Question: Judging by this figure, is the value going up or going down?
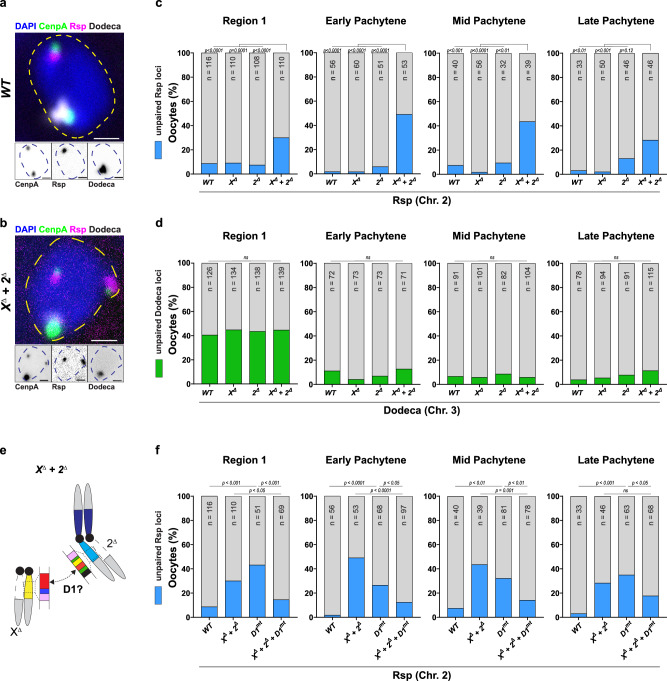
Answer: increasing